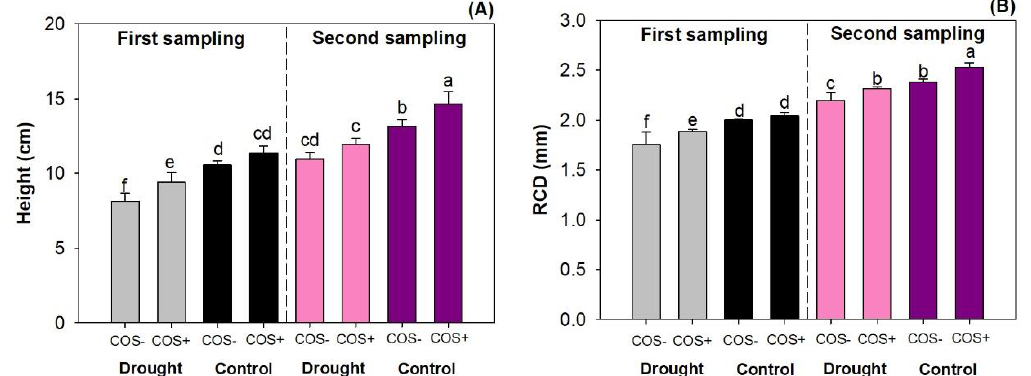
Figure 1. Height ( A ) and root-collar diameter (RCD) ( B ) in two harvests of Buddhist pine ( Podocarpus macrophyllus ) seedlings exposed to chitosan oligosaccharide (COS) addition (COS- vs. COS+) under contrasting water availabilities (drought vs. irrigated control). Different letters indicate a significant di ff erence according to Tukey’s test at the 0.05 level. Error bars stand for standard errors.